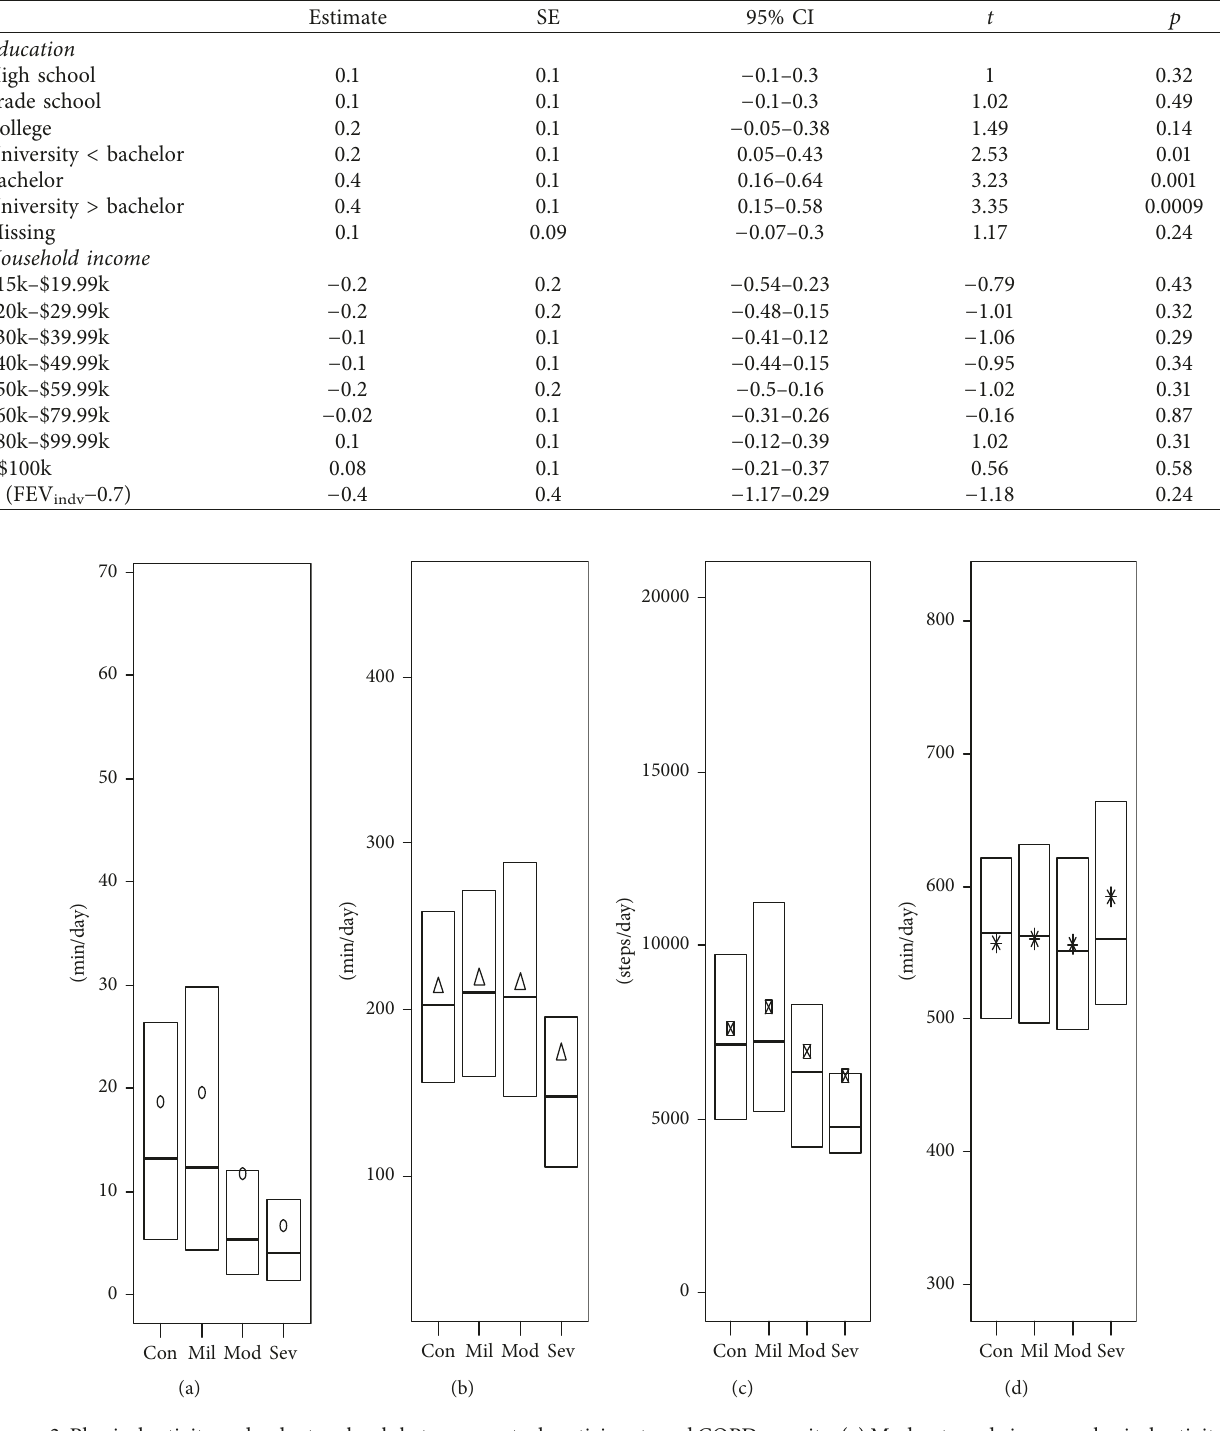
Figure 2: Physical activity and sedentary levels between control participants and COPD severity. (a) Moderate and vigorous physical activity (MVPA). (b) Light physical activity (LPA). (c) Steps. (d) Sedentary. Con � control, Mil � COPD mild severity, Mod � COPD moderate severity, Sev � COPD (very) severe. The whiskers are voluntary missing because Statistics Canada does not allow figures with individual